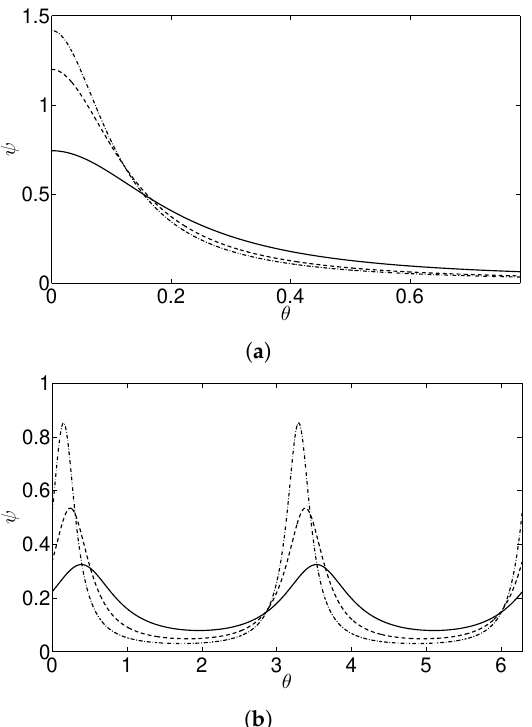
Figure 1. ( a ) The radially averaged probability distribution ¯ ψ for elongational flow for ˙ ε = 1 with f = 0,0.5 and 0.75, denoted by the solid, dashed, and dot-dashed lines, respectively, in the upper quadrant 0 < θ < π . ( b ) The radially averaged distribution under shear flow, with ˙ γ = 4